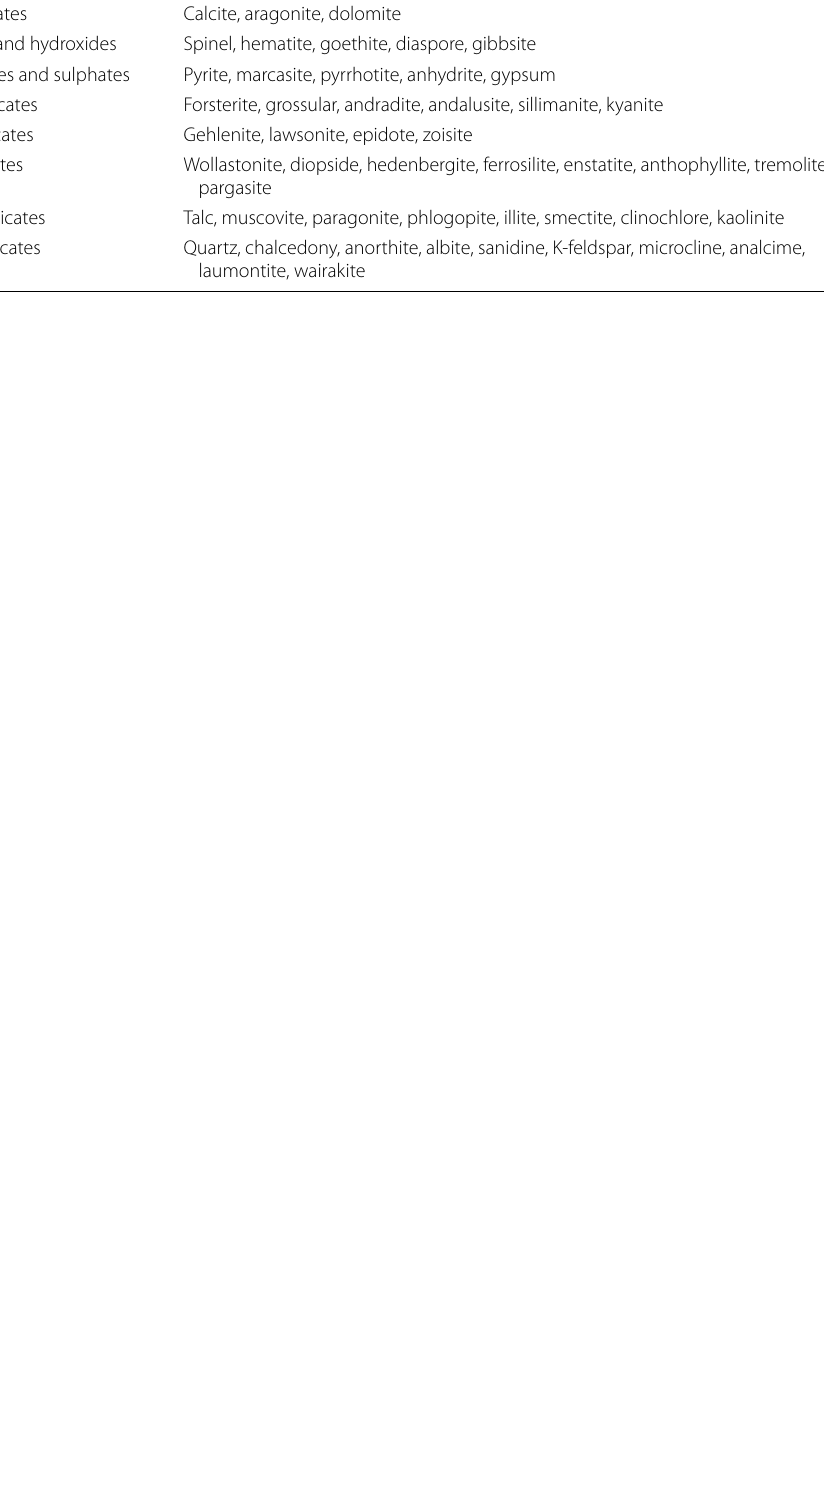
Table 5 The unspecific mineral set, ordered in groups of minerals and their associated phases Mineral